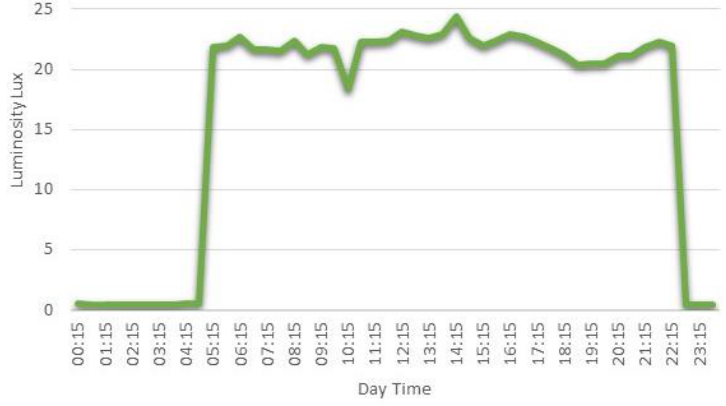
Figure 7. Light meter average measurements of the days 12 to 14 March in the monitored classroom.